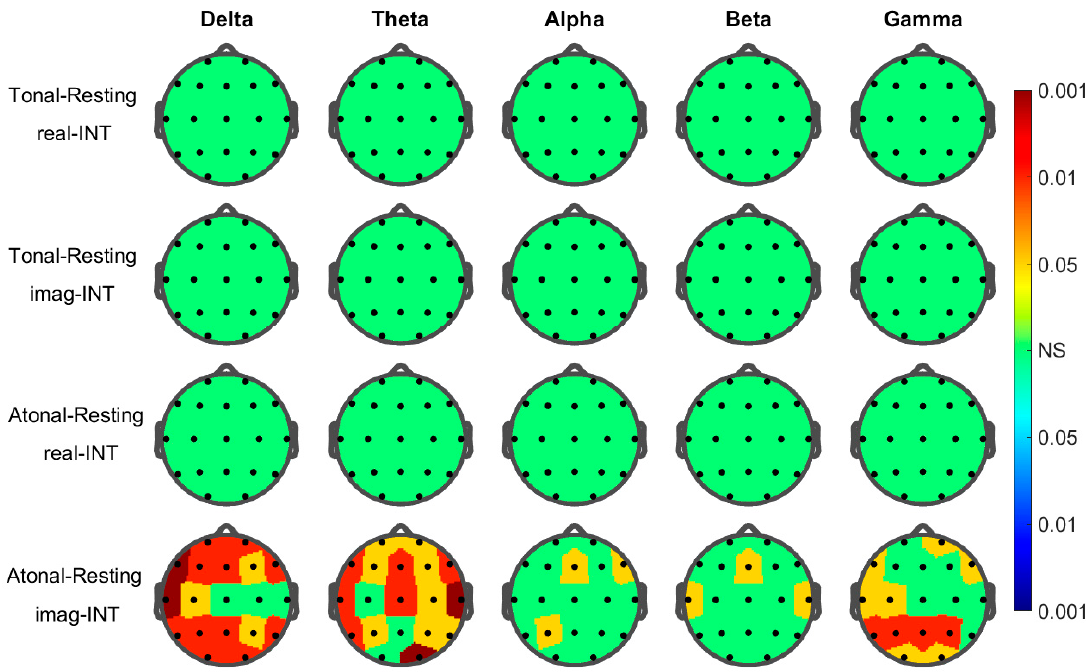
Figure 4. As in Figure 3 but for the normalized local efficiency.